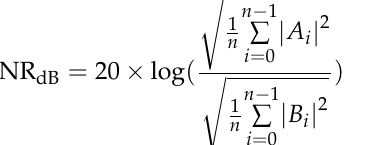
Figure 5. SNR measurement devices.